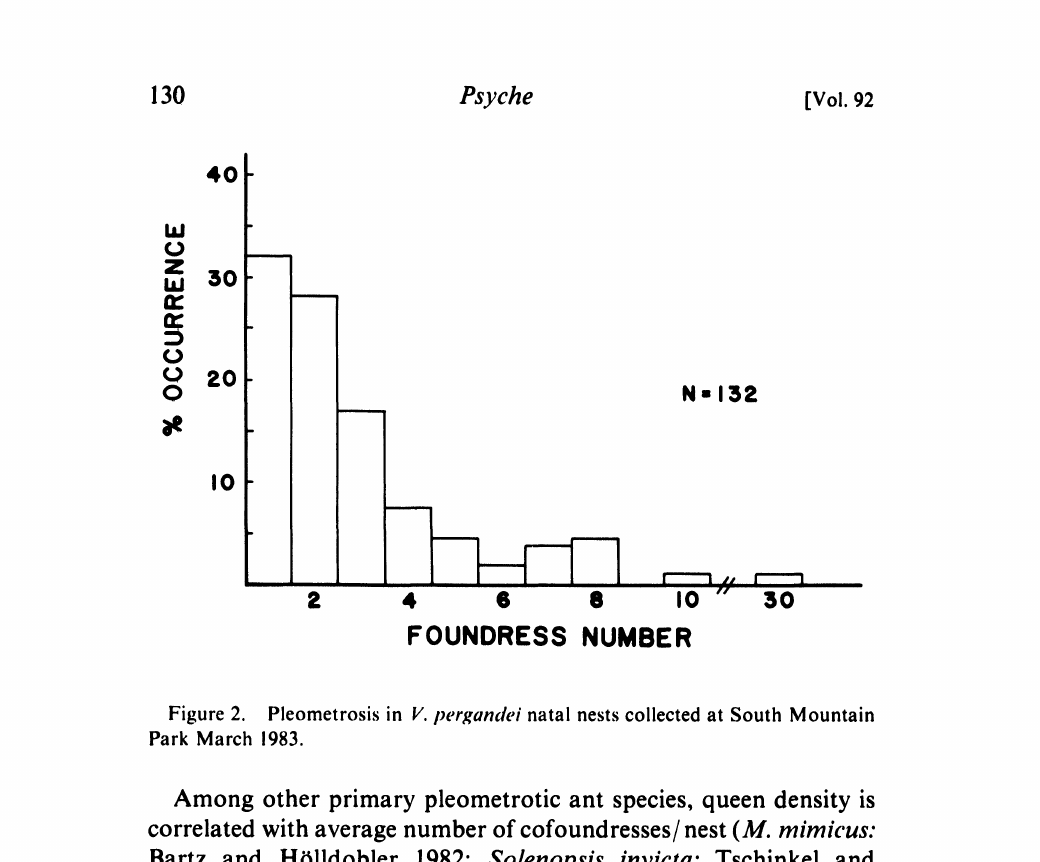
Figure 2. Pleometrosis in V. pergamh, natal nests collected at South Mountain Park March